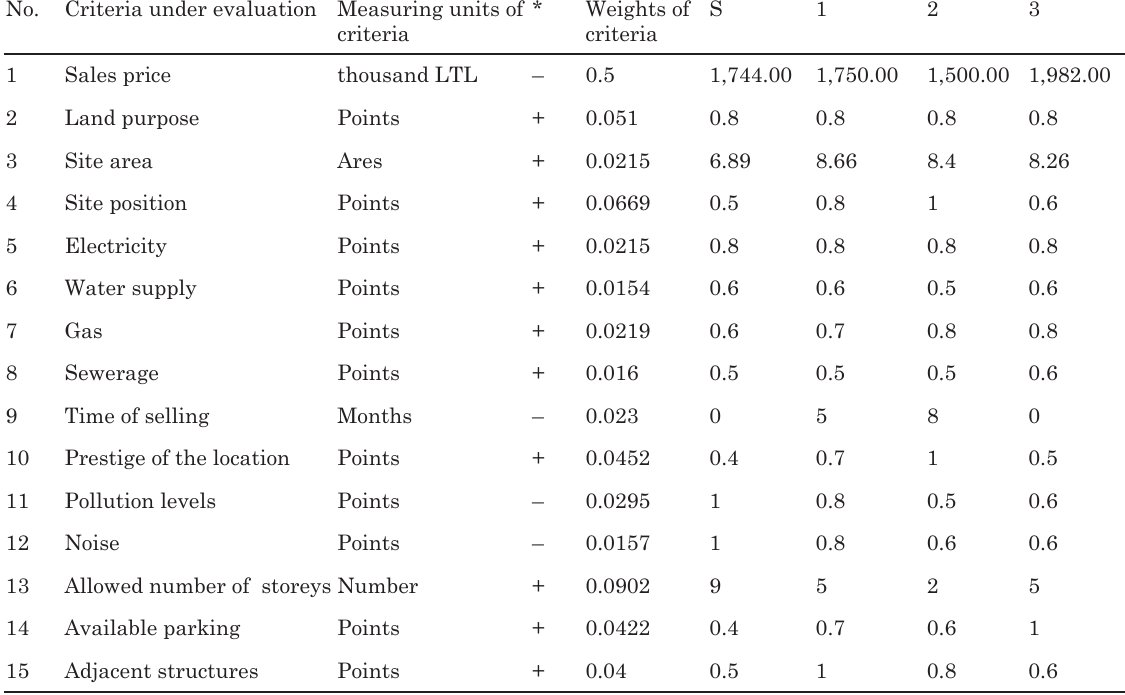
table 1. initial data for multiple criteria decision-making related to the site no. Criteria under evaluation measuring units of